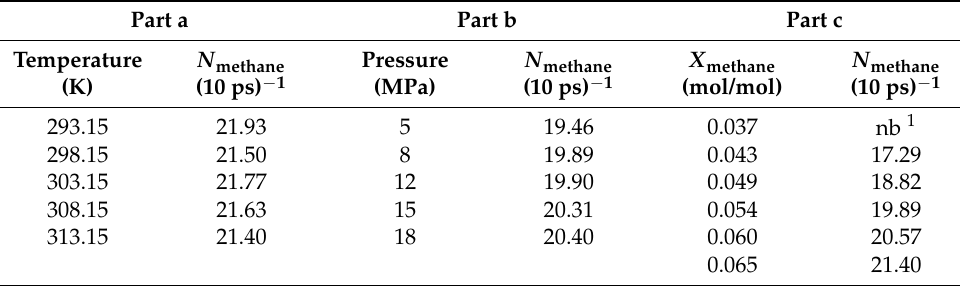
Table 3. Time-averaged N methane exchanges between the bubbles and the solution per 10 ps in (a) Sys6_8MPa at different temperatures, (b) Sys4 at 313.15 K and at different pressures, and (c) systems with different X methane values at 313.15 K and 8 MPa.